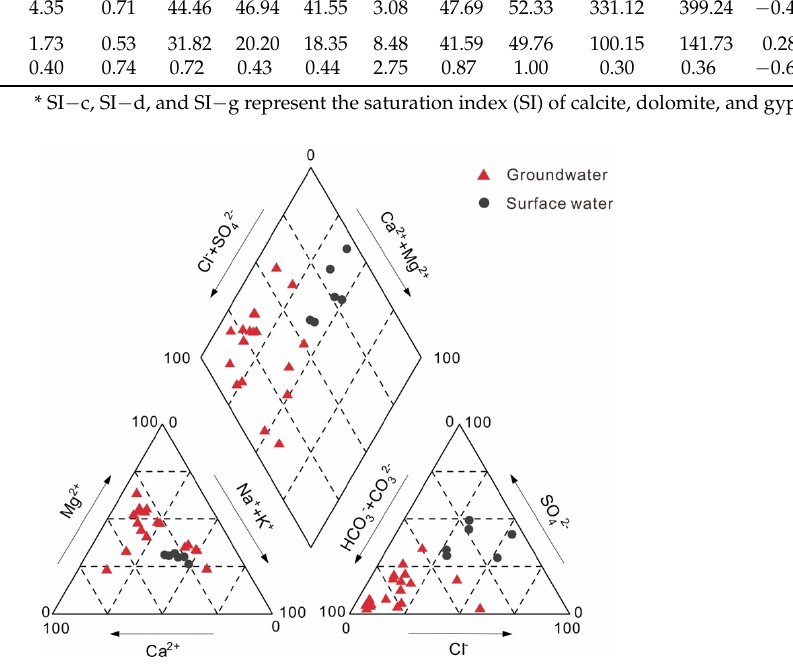
Figure 2 . The piper diagram of surface water and groundwater samples in the mining area. The arrows point from high ion content to high ion content in water.